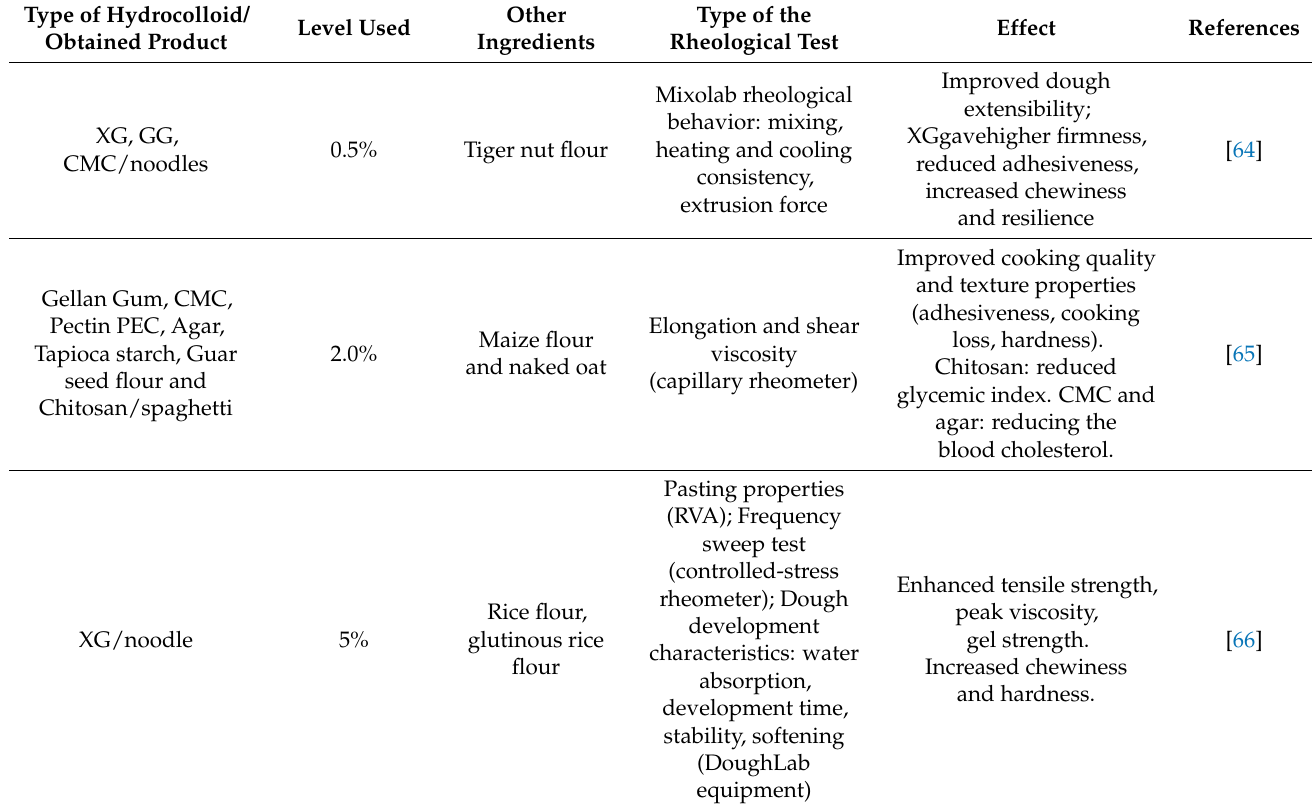
Table 5. Effect of hydrocolloids in GF